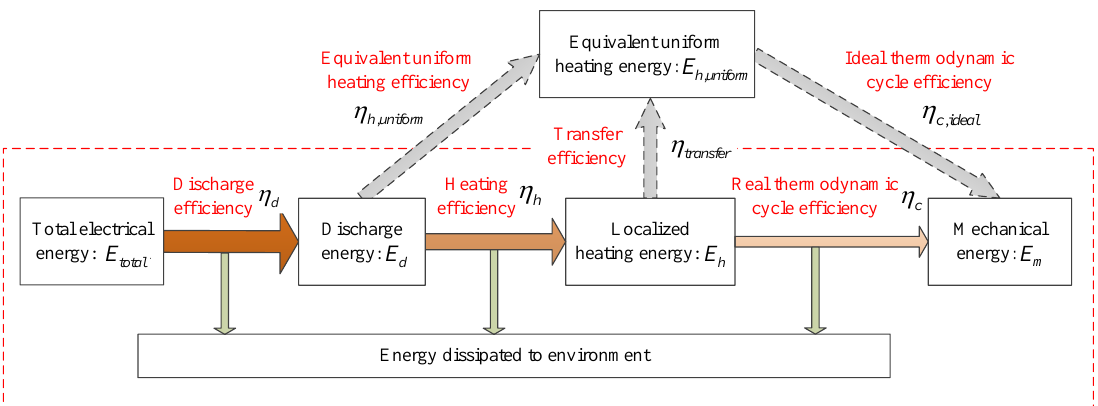
Figure 13. Energy flow in the plasma synthetic jet actuator system (reproduced from [28]). Note that the processes outside the red dash box as well as the pertinent efficiencies ( η h ,uniform , η transfer and η c ,ideal ) are not